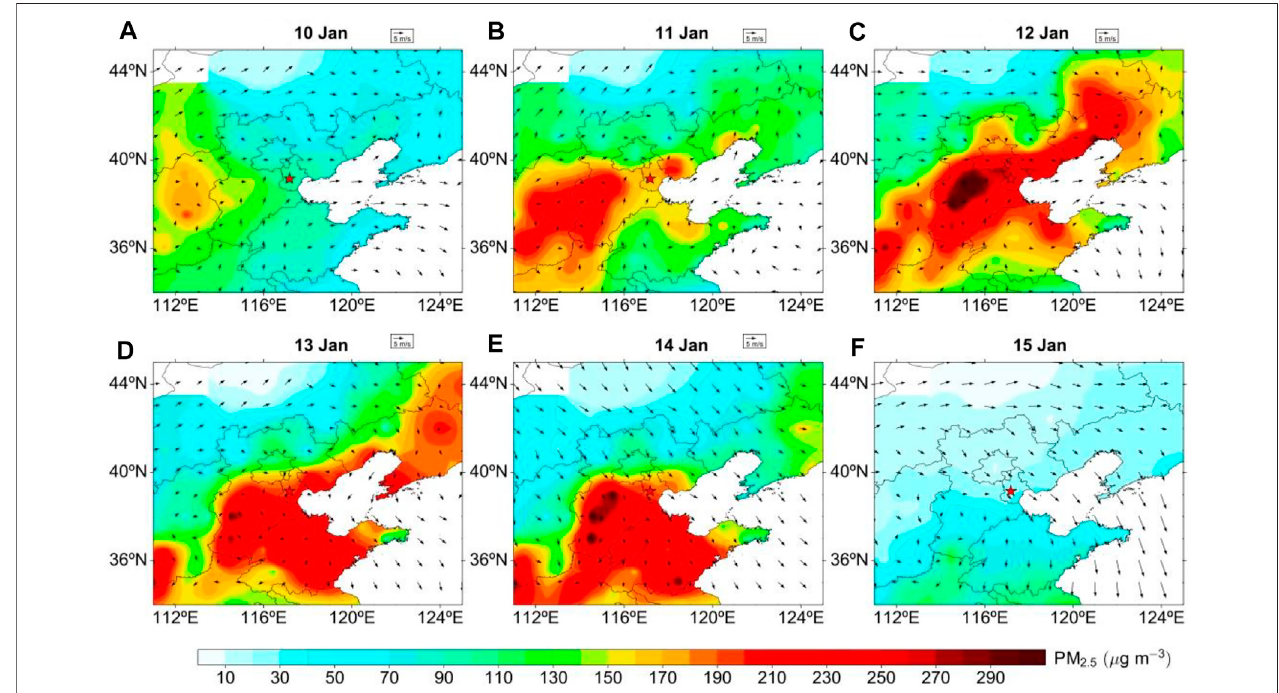
FIGURE 5 | Spatial distribution of daily PBL height from 10 to 15 January 2019 in Tianjin shown in (A – F) .